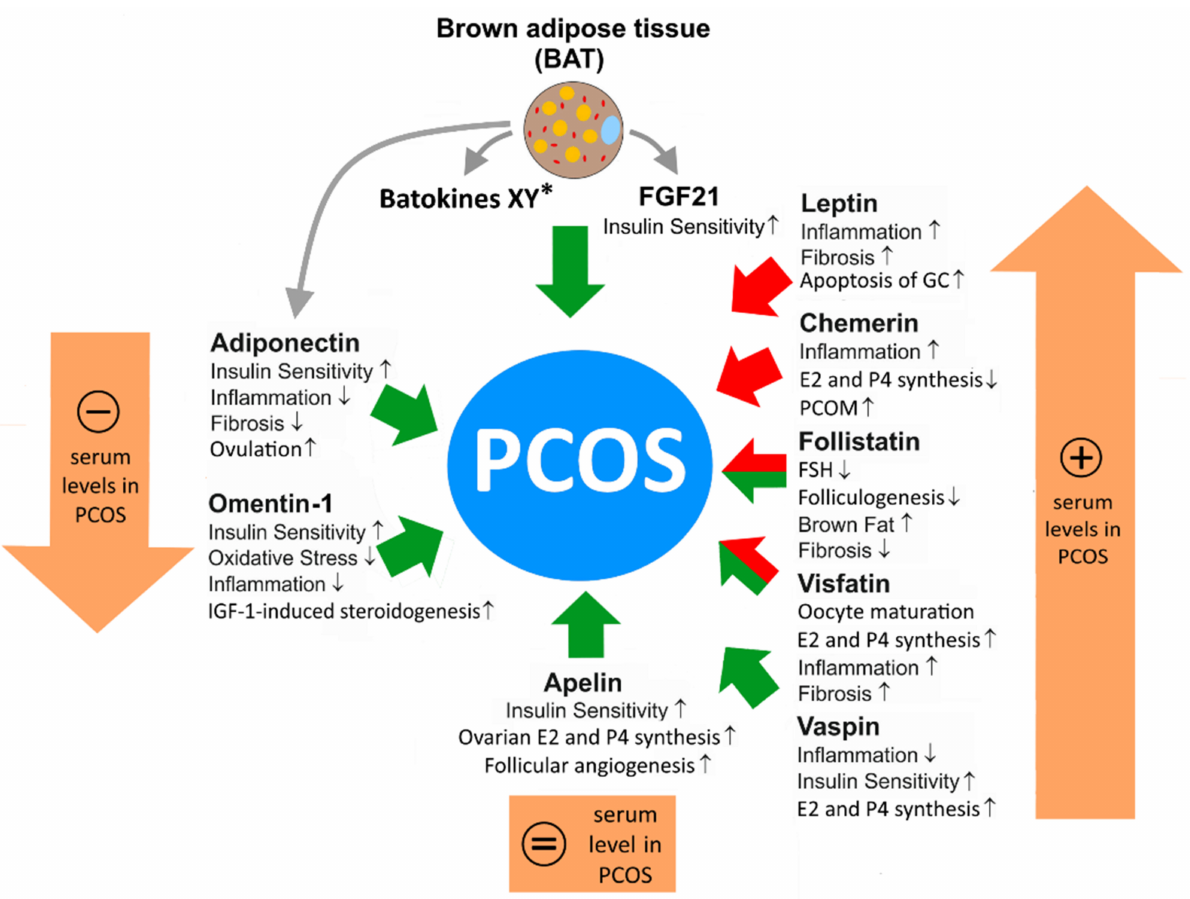
Figure 1. Proposed effects of the indicated WAT adipokines and of BAT on PCOS, based on current experimental evidence and on an assessment of the effects of the known adipokine actions on PCOS. Green arrows illustrate a beneficial effect, red arrows an adverse effect on PCOS pathophysiology. Red-green-colored arrows indicate the presence of both beneficial and adverse effects of an adipokine. BAT activation or transplantation has been reported to notably improve PCOS, although only few molecular mechanisms underlying this effect are known to date. * Novel proteomic approaches are expected to identify further batokines (XY) affecting PCOS. “ ↑ ” = increase; “ ↓ ” =